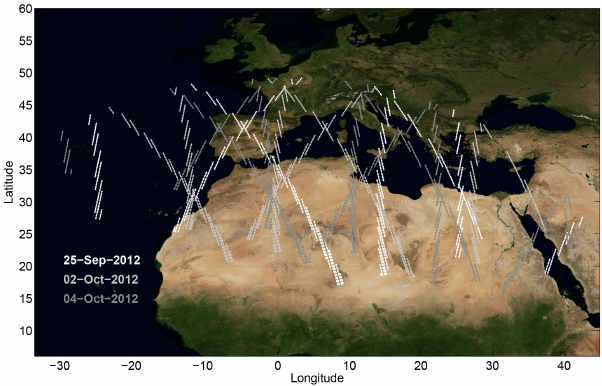
Figure 8. Footprint positions of IASI observations for the GSICS IASI/SEVIRI inter-calibration